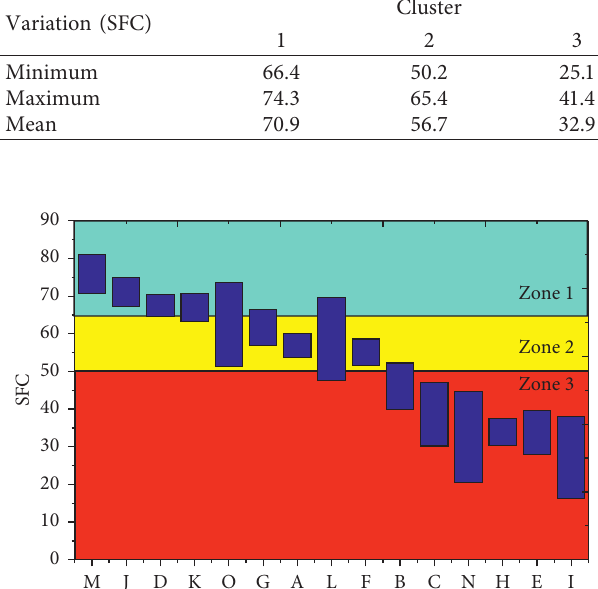
Figure 6: Results of the antiskid zone of concrete